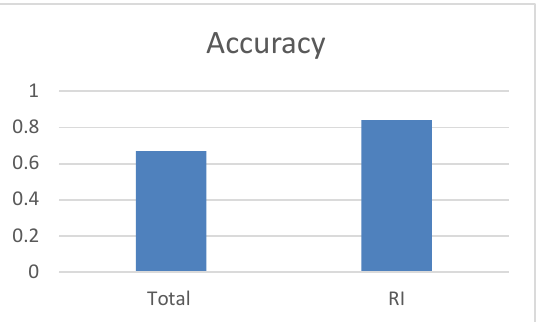
Figure 4. Accuracy of all cases and RI